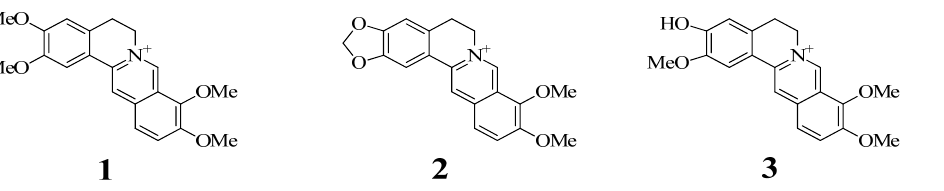
Figure 1. Structure of quaternary isoquinoline alkaloids ( 1 – 3 ).